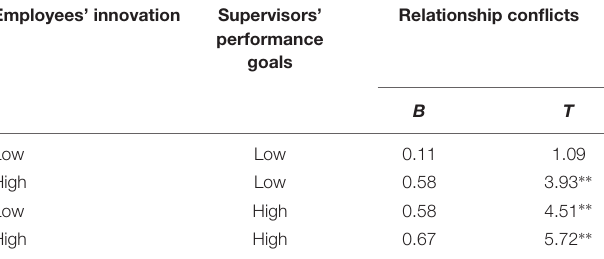
TABLE 4 | Conditional relationship between EI and relationship conflicts at low and high values of EEG and